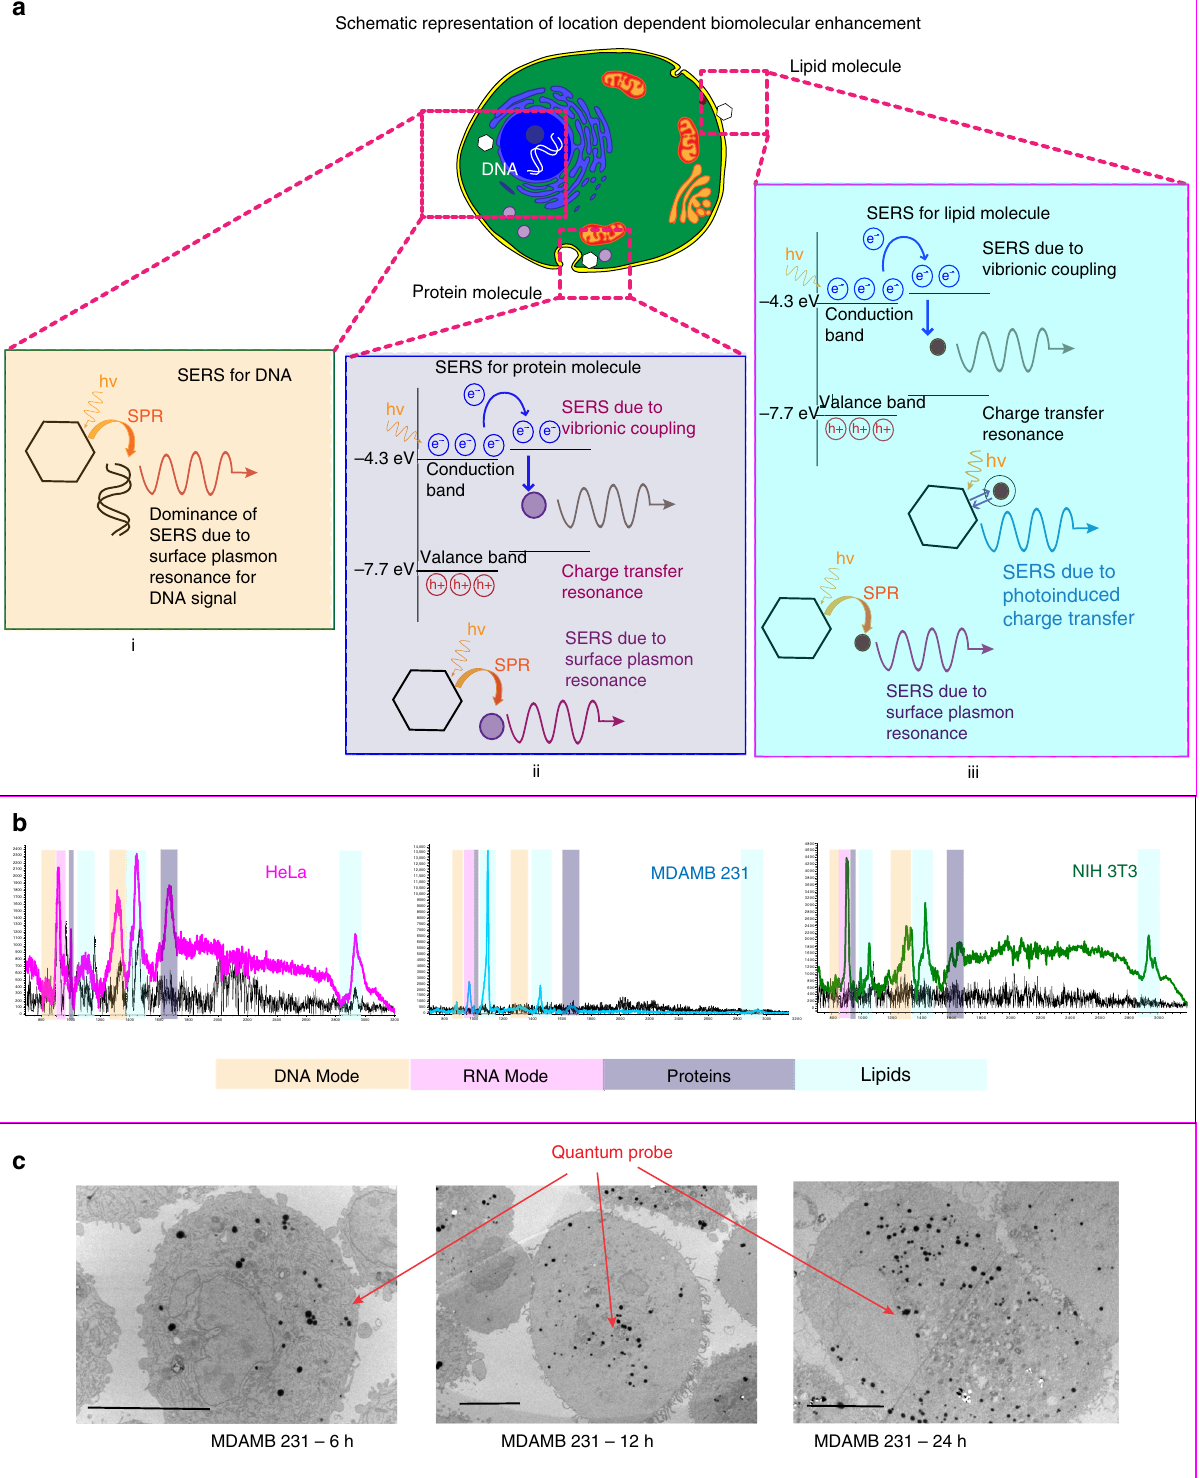
Fig. 7 In vitro SERS with ZnO-based semiconductor quantum probe. a Schematic representation of biomolecular enhancement based on dominance of various resonances due to the location of the biomolecules inside the cells. (i) Less probe inside the nucleus due to time-dependent cellular uptake. Less enhancement as less availability of the charge transfer resonance providing 2 – 3-fold enhanced signal. (ii) Cytoplasm was bene fi ted by the cumulative resonances of charge transfer as well as surface plasmon providing 5 – 6-fold enhanced signal for proteins. (iii) Maximum enhancement was observed for lipids in the close proximity of the quantum probe, generating 10 – 15-fold enhanced signal. b Enhanced SERS signal for cancer and non-cancer cells. Magenta, cyan and green represent SERS signal and black spectra for non-SERS response. The “ x ” axis of the spectra display Raman shift (cm − 1 ) and “ y ” axis displays arbitrary units. c Cell TEM reveal time-dependent cellular uptake of the quantum probes. Scale bar = 10 µ